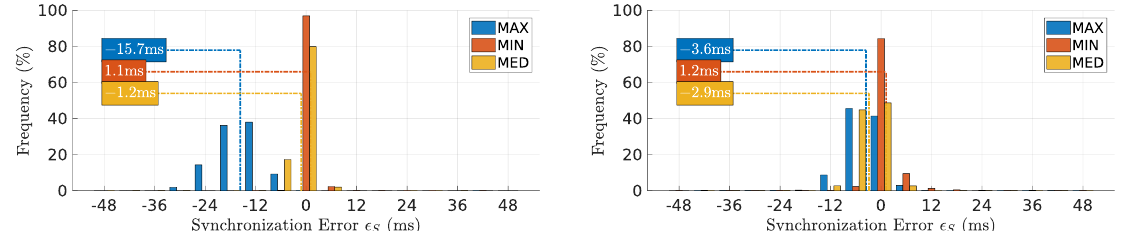
Figure 8. Distribution of synchronization error (cid:101) S on the first and second relays, left and right respectively. MIN shows the smallest synchronization error with a light overlap. MED , delay’s